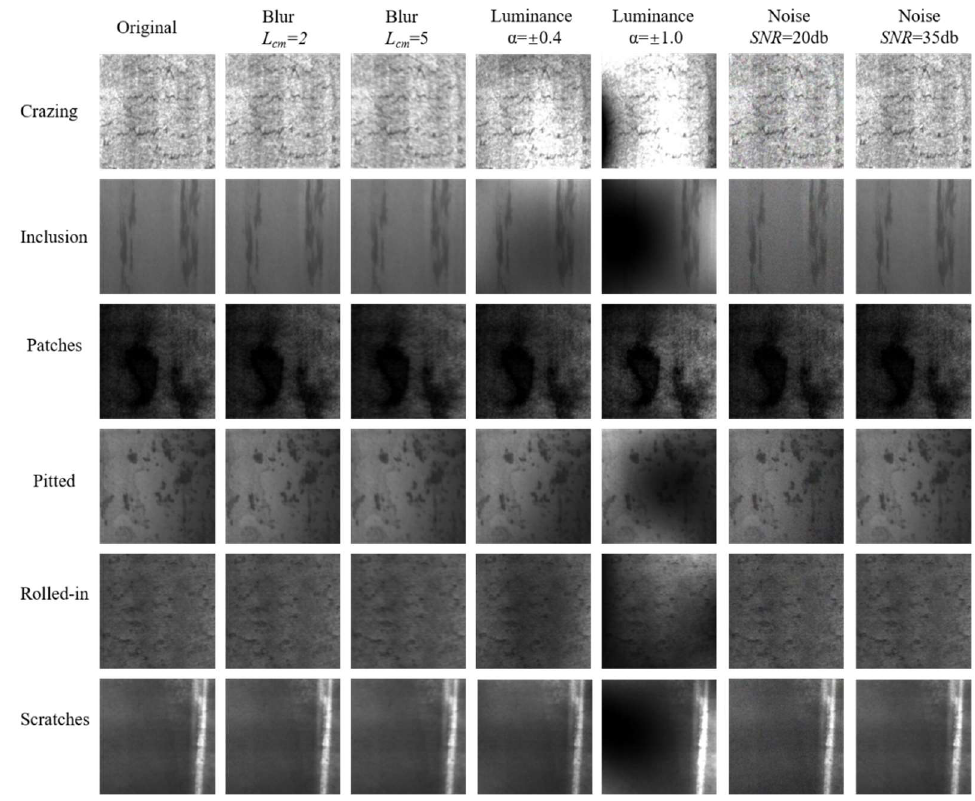
Figure 6. Sample images of six typical surface defects in NEU-CLS dataset after processing.